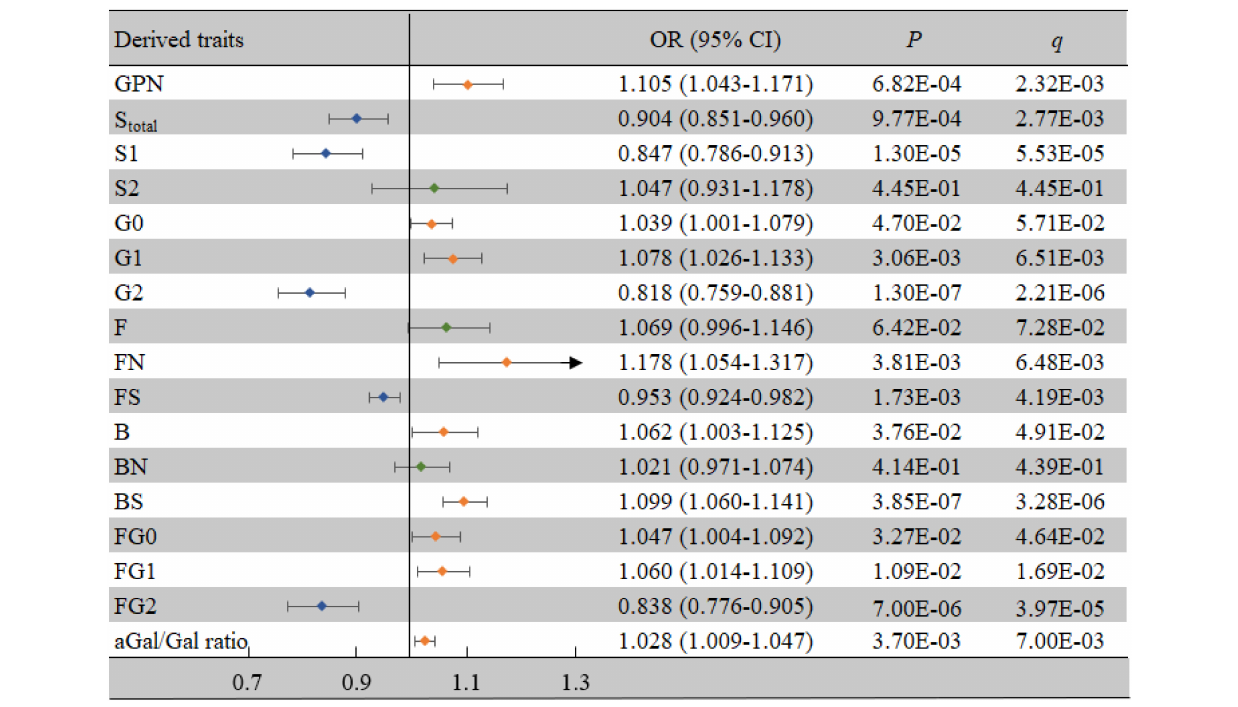
FIGURE 3 | Associations of the derived traits and VCI as determined by multivariate logistic regression analyses. P < 0.05 was considered statistically significant using logistic regression analysis; q < 0.05: significant after correction using FDR. The multivariate logistic regression analyses were performed after adjusting for age, BMI, education, income, smoking, drinking, salt intake habit, hypertension, hyperlipidemia, and diabetes mellitus. B, bisecting GlcNAc; BMI, body mass index; CI, confidence interval; F, core fucose; FDR, false discovery rate; G, galactose; N, neutral glycans; OR, odds ratio; S, sialic acid; VCI, vascular cognitive impairment.